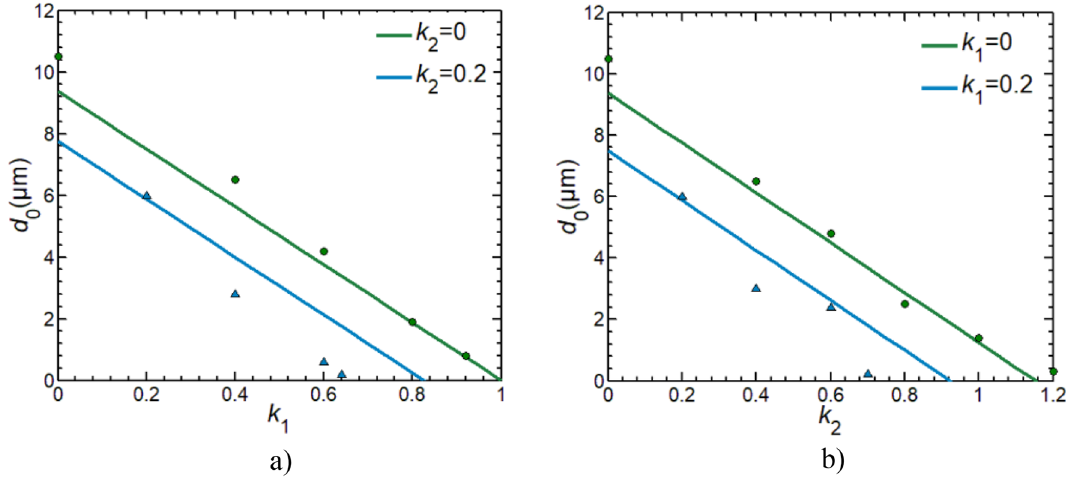
Figure 6. Changes of machining precision along with gains k 1 and k 2 . lines: calculated d 0 . triangles and circles: tested d 0